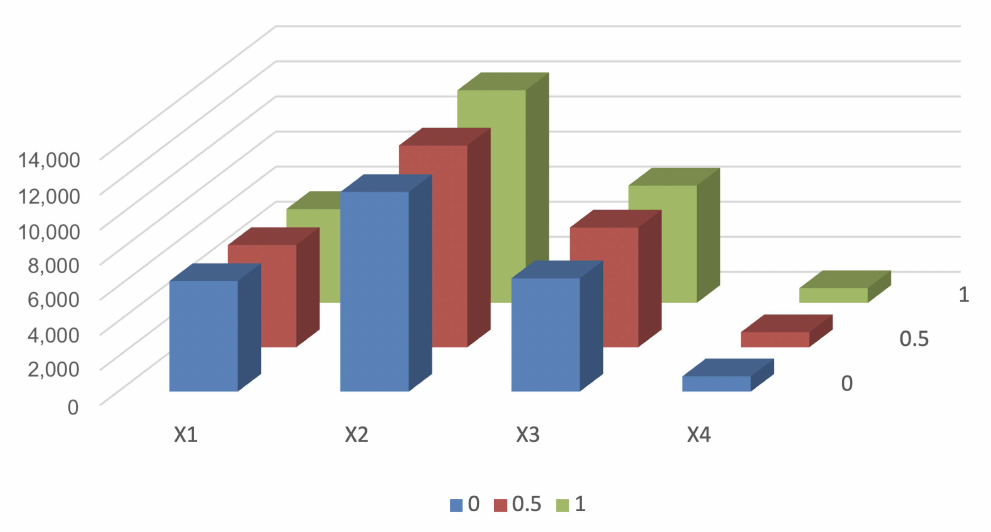
Figure 2. Vendor’s quota.